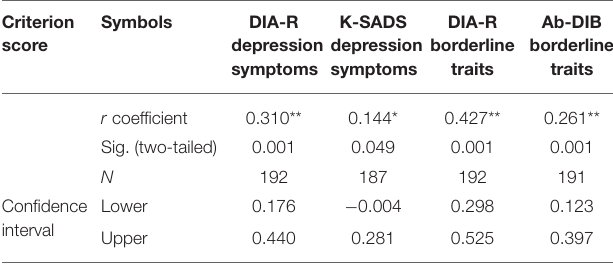
TABLE 3 | Pearson’s correlations for concurrent